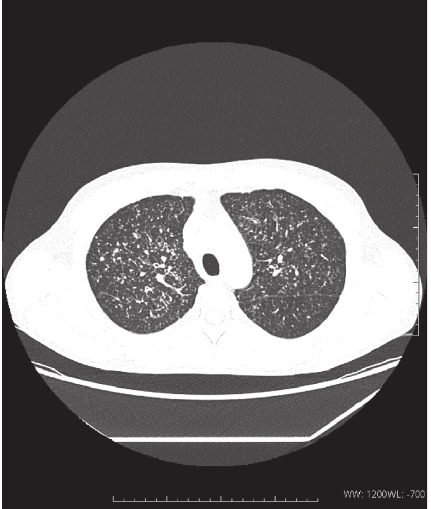
Figure 3: Axial chest computed tomography with the presence of innumerable small (2–4mm) pulmonary nodules with a cen- trilobular predilection, consistent with miliary tuberculosis.